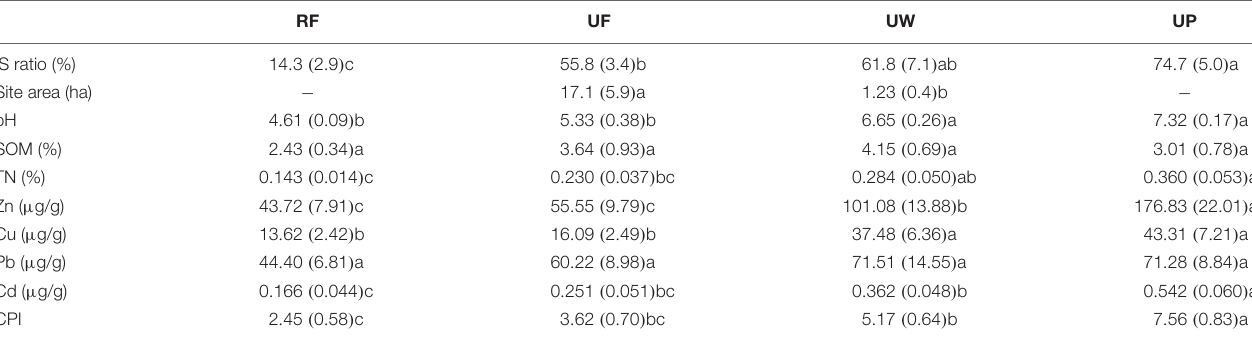
FIGURE 4 | Variations of soil mesofauna abundance and soil property with site area. R 2 and p were the fitness and significance of the linear regression models. Note that sites that belonged to rural forest and urban park were excluded in the regressions. The “ × ” indicates the data point not included in the line regression analysis. TABLE 2 | Mean values (SE) of landscape trait and soil property in rural forest (RF), urban forest (UF), urban woodland (UW), and urban park (UP). RF UF UW